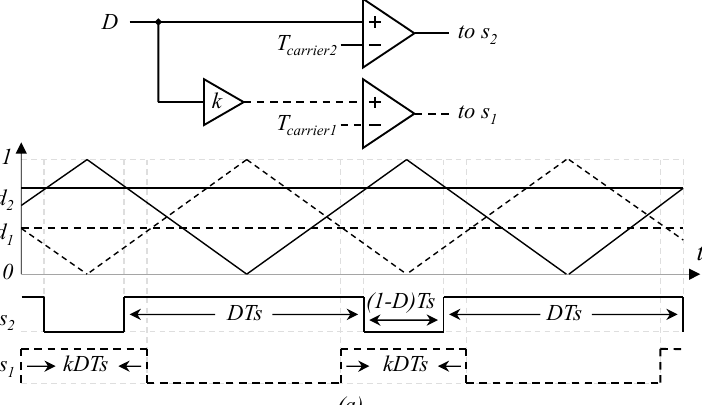
Figure 4. PWM important waveforms in the proposed converter when D > D Z .